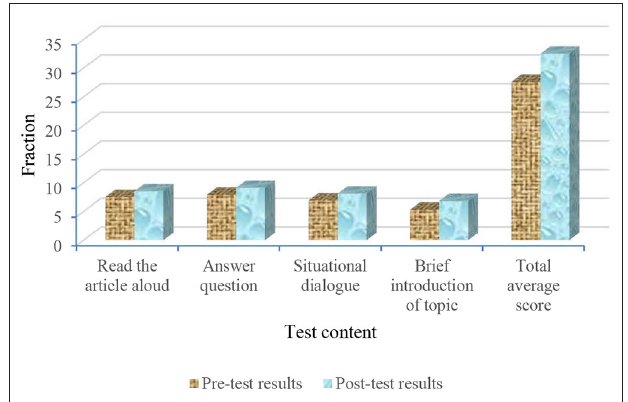
FIGURE 8 | Comparison of pre-test and post-test scores of students in class A.